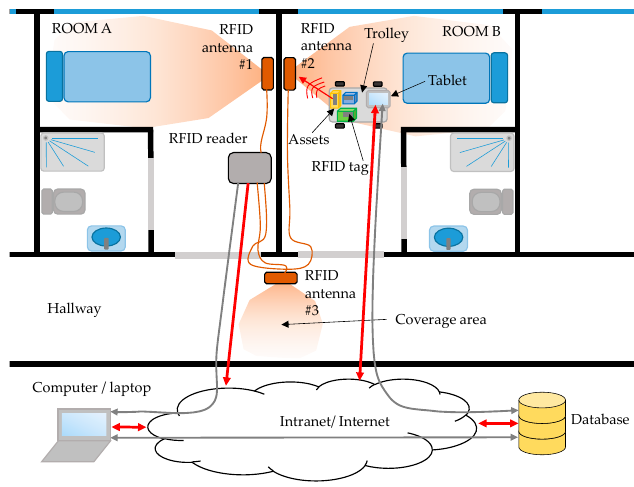
Figure 6. Scheme of the RFID system architecture used for the proof-of-concept. Sensors 2018 , xx , x FOR PEER REVIEW